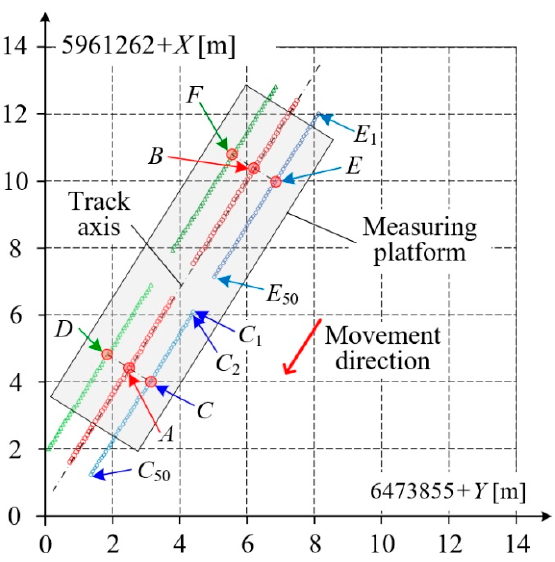
Figure 6. Results acquired on the straight horizontal track.